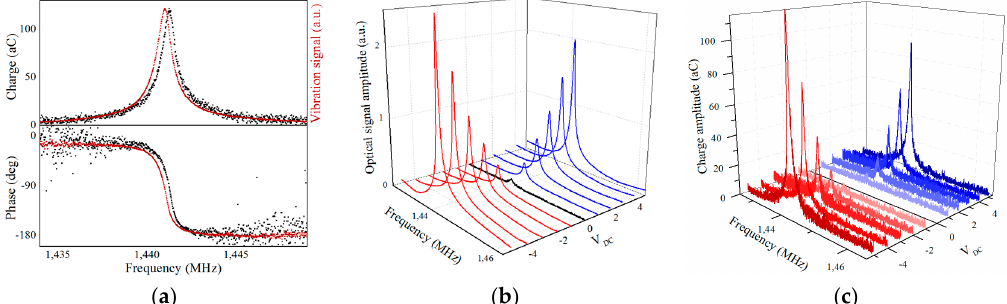
Figure 2. ( a ) Charge (black dots) and optical (red dots) measurements of the cantilever device resonance versus frequency when driven by V DC = − 5 V and V AC = 600 mV applied to the chromium top electrode; ( b ) Measurement by optical interferometry of the magnitude signal close to resonance for V DC values ranging from − 5 to +5 V; ( c ) Charge magnitude measurement close to resonance for V DC values ranging from − 5 to +5 V. The charge curves were obtained by averaging 6